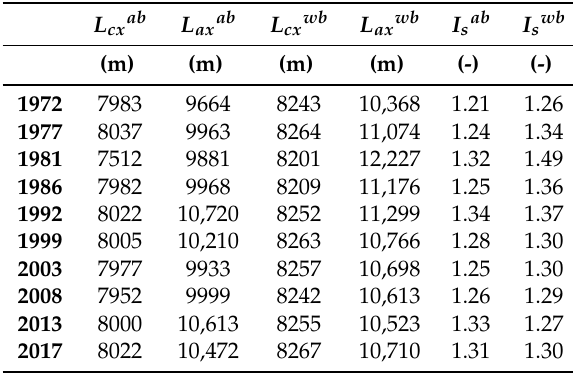
Table 8. Cartesian ( · cx ) and axial ( · ax ) lengths ( L ), sinuosity index ( I ) of active ( · ab ) and wet ( · wb ) channels, extracted from the elaboration of the Shkumbin River LANDSAT imagery, time period